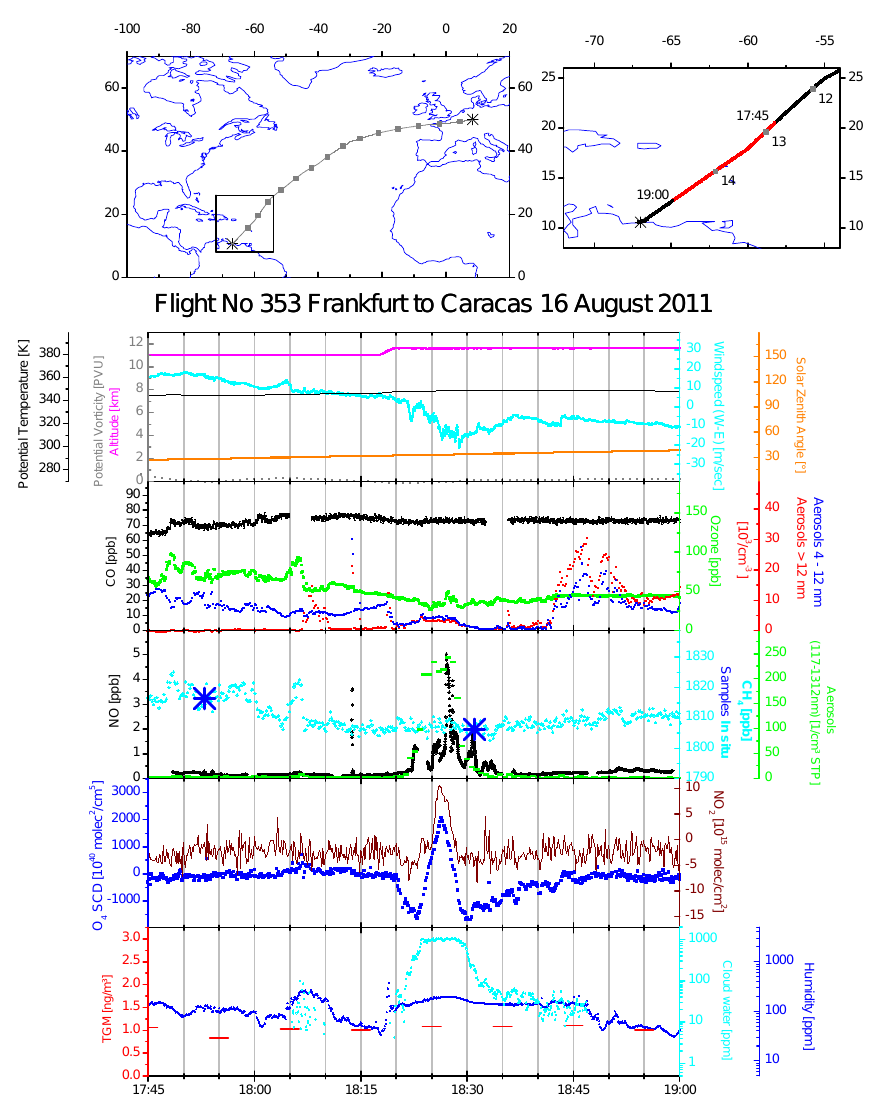
Figure 2. Overview of selected CARIBIC measurements around the cloud (18:25 UTC). On top a map with the complete flight is shown. The box illustrates the area of the zoomed map, where the part of the flight track between 17:45 and 19:00UTC (Table 3) is shown in red and the positions of the last three air samples (12, 13, 14) are shown. The cloud is recorded by the cloud water data (lowermost panel). Concomitant NO and DOAS data show some interesting features. The strong variability of NO might be attributed to lightning activity in the cloud system. The DOAS (O 4 and NO 2 ) data shown here, come from the nadir